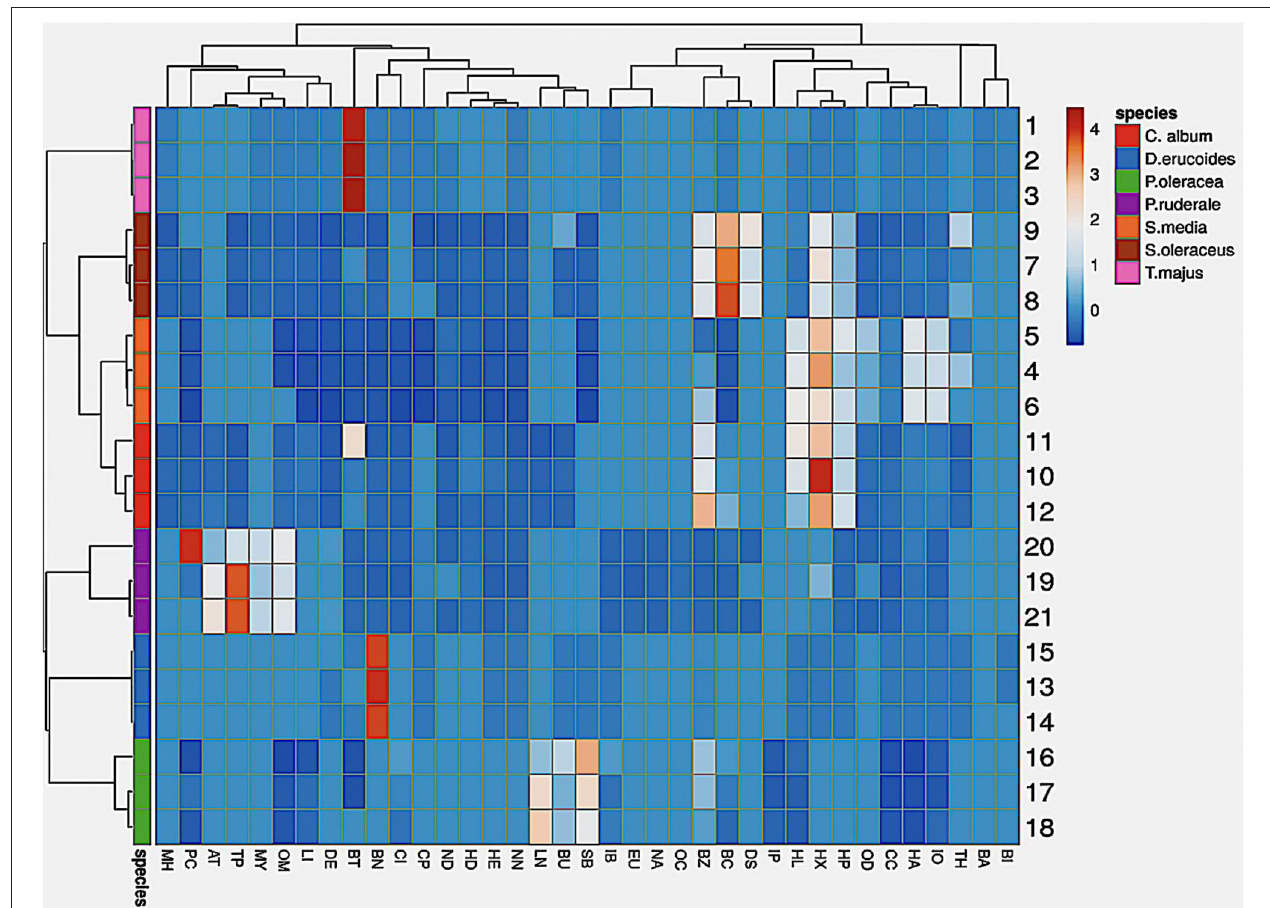
FIGURE 4 | Hierarchical cluster analysis for identified volatile compounds in the seven undervalued species. Data represent the average value compounds ( n = 3) for each studied plant. For the code of the compound identities, refer to Table 1